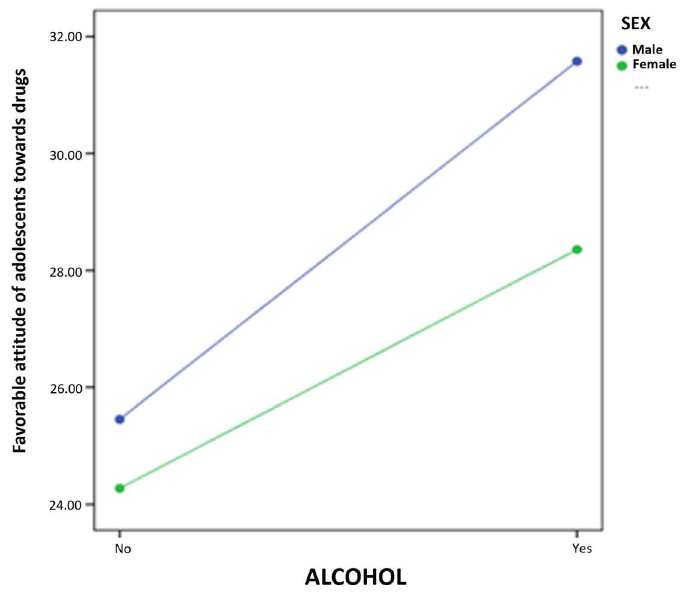
Figure 1. Interaction of alcohol use and sex in the prediction of favorable attitude toward drugs in adolescents.